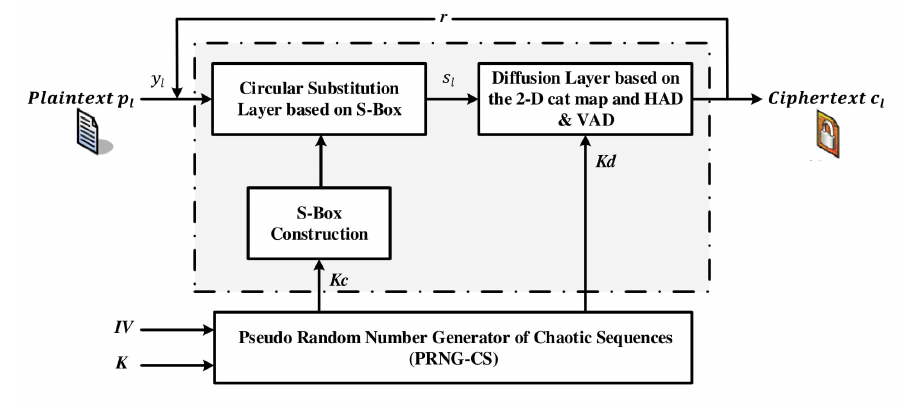
Figure 1. Diagram of the encryption process.